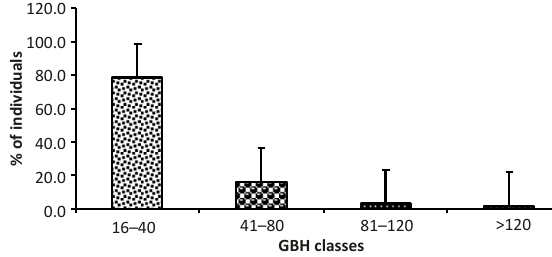
Figure 4. Proportional distribution of tree species across girth intervals.